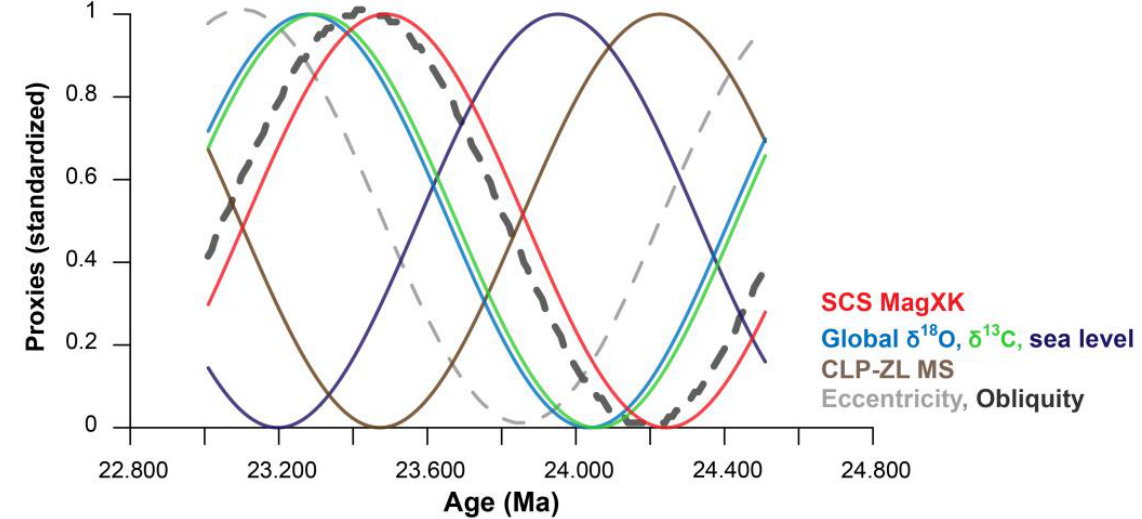
Figure 8. Comparison between paleoenvironmental proxies. All data were from low-passed-filtered components (FFT filter >1.0 Myr). See Figures 6 and 7.